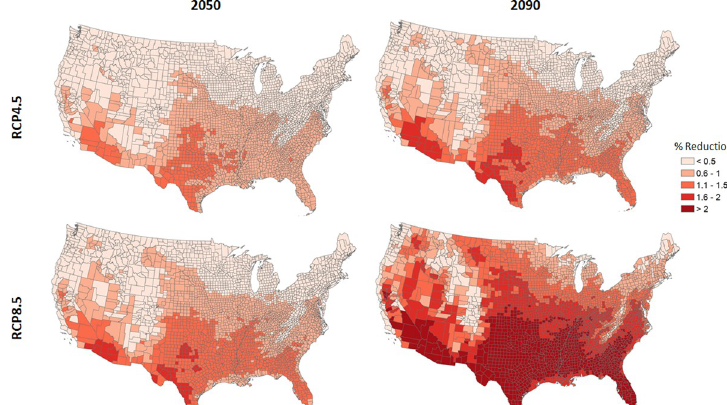
Fig 2. Projected percent change in future labor hours per worker. Percent reductions relative to a 40.5-hour work week, as observed among high-risk workers using data from the Bureau of Labor Statistics in 2009. These results represent an average across the six